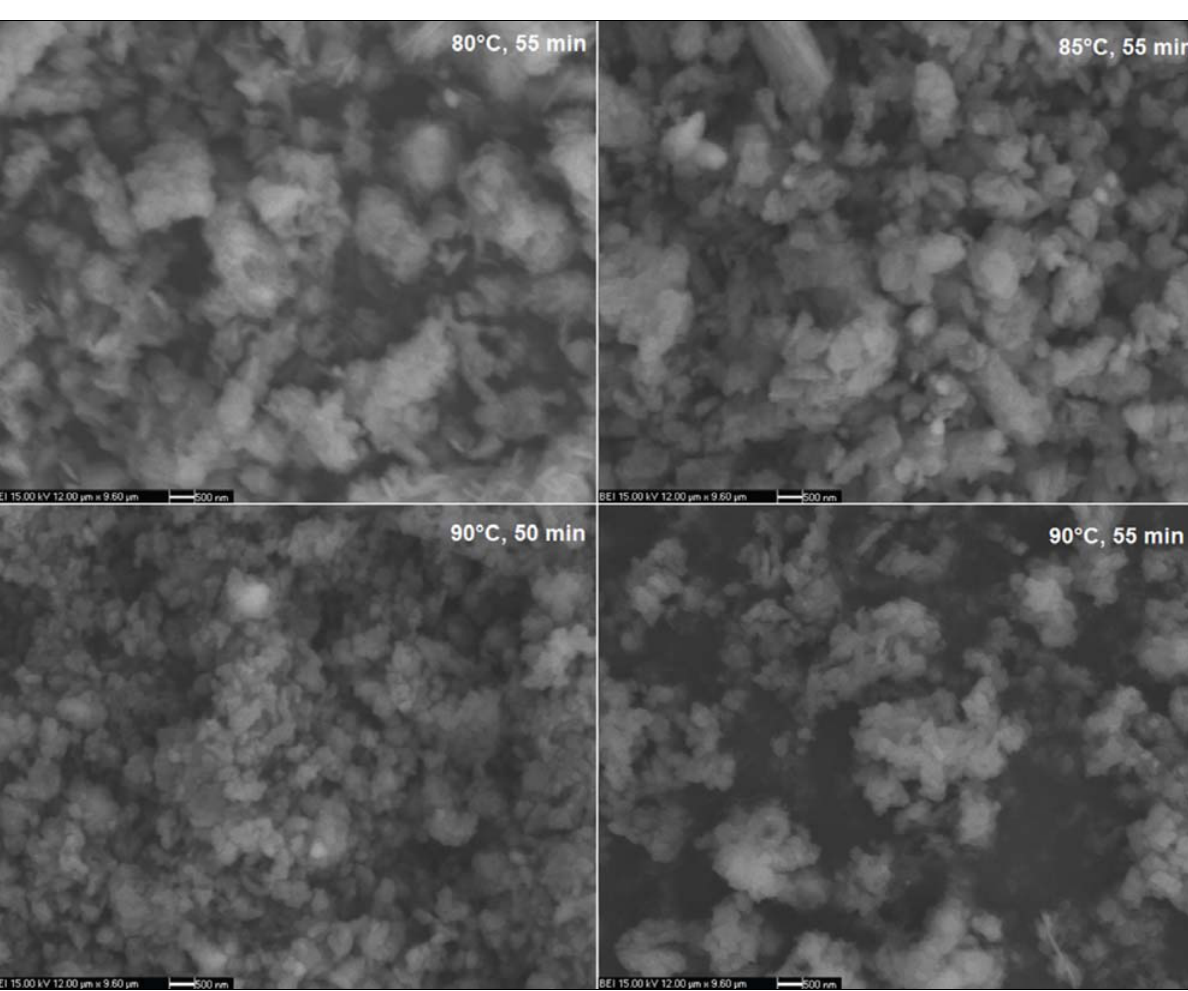
Fig. 4. SEM images of the synthesized pure zinc